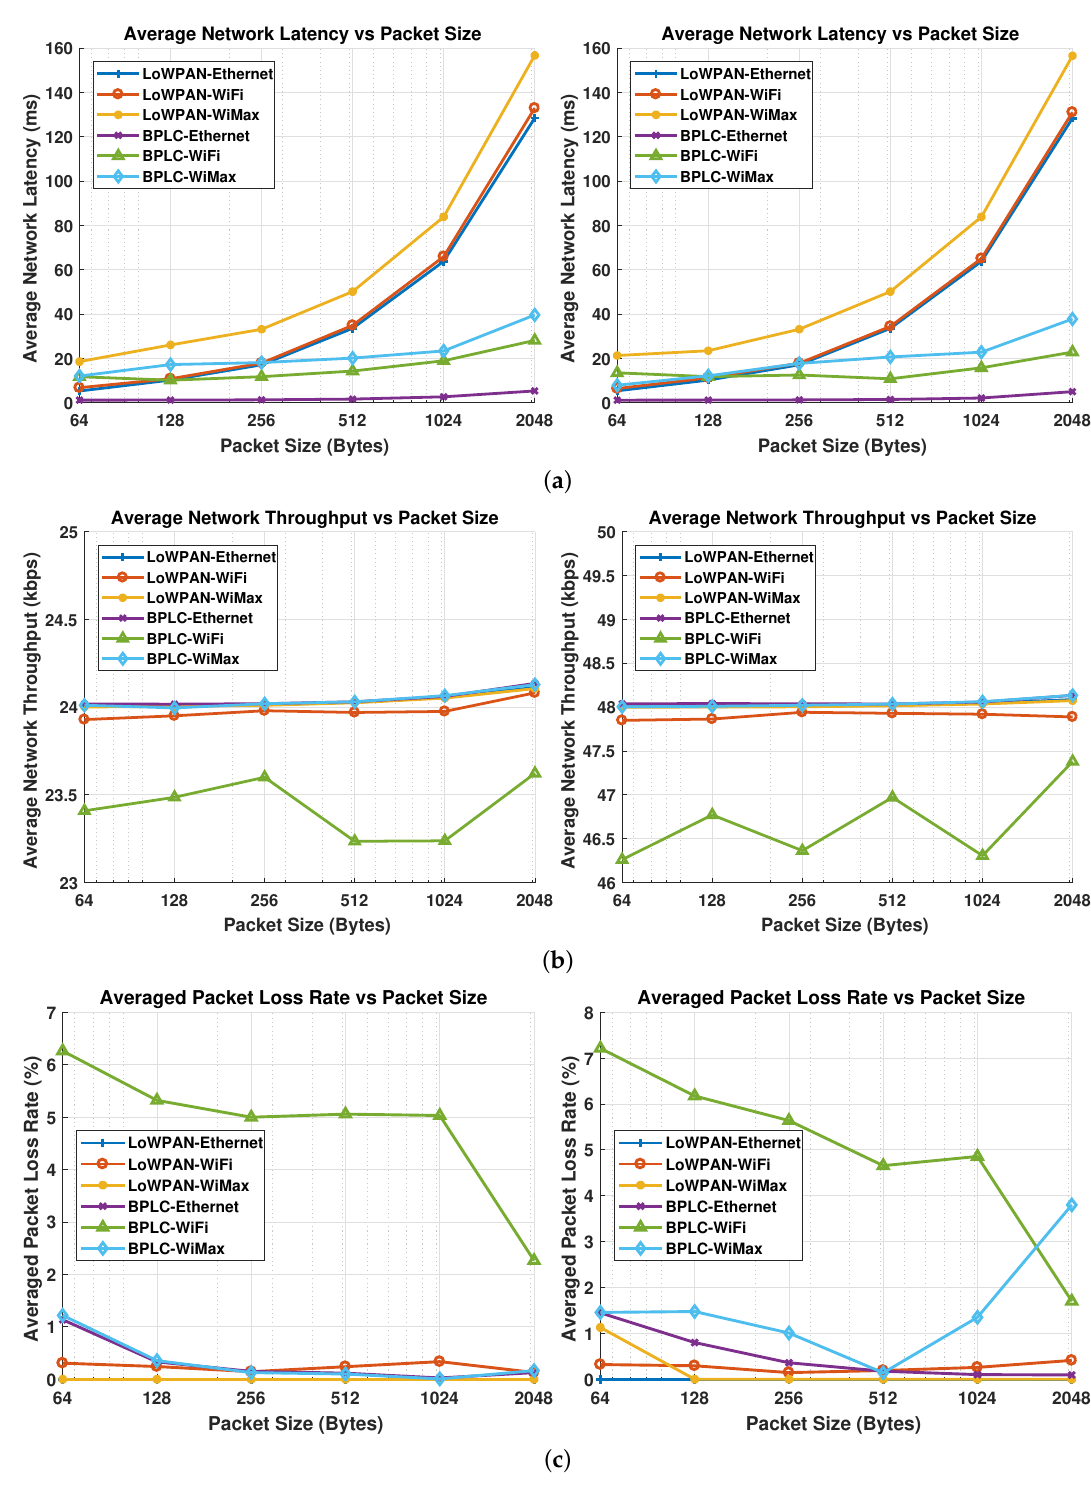
Figure 4. Performance comparison of six hybrid communication designs in terms of UDP packet size and data rate–BPLC. ( a ) Latency for data rate 24–48 Kbps; ( b ) Throughput for data rate 24–48 Kbps; ( c ) Packet Loss Rate for data rate 24–48